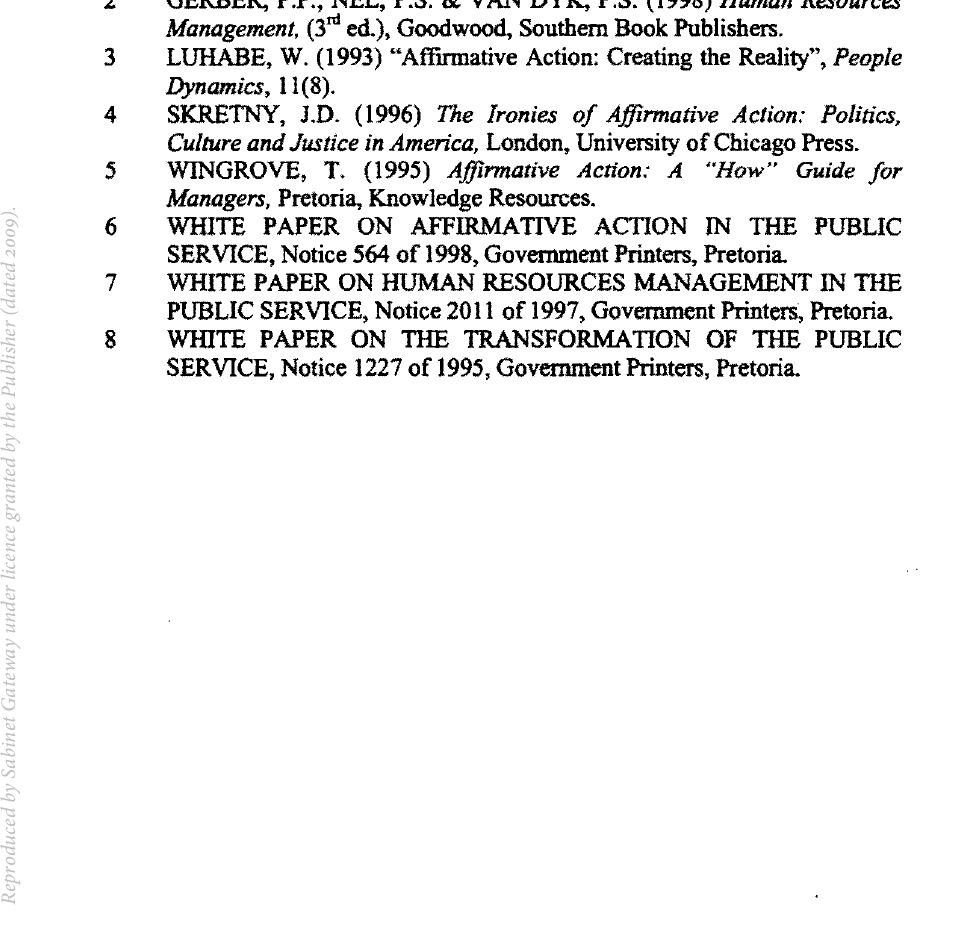
SERVICE, Notice 564 of 1998, Government Printers, Pretoria.